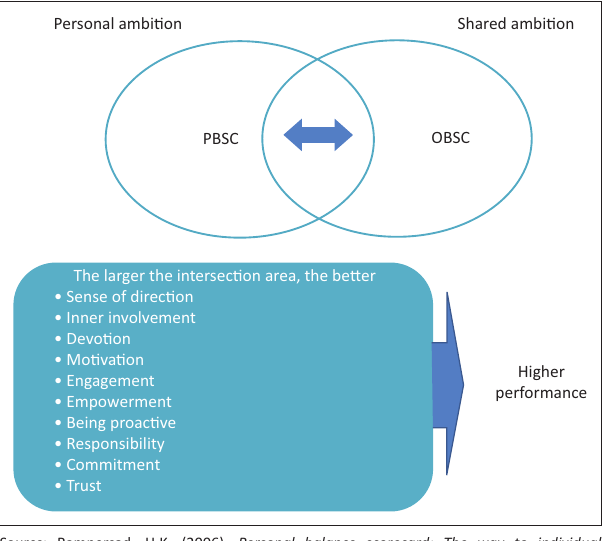
FIGURE 2: Match between personal ambition and shared